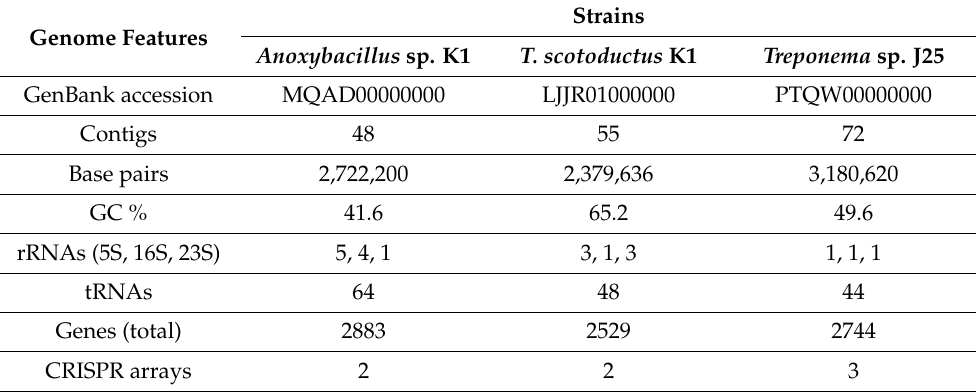
Table 3. Genome features and statistics of strains Anoxybacillus sp. K1, T. scotoductus K1, and Treponema sp.